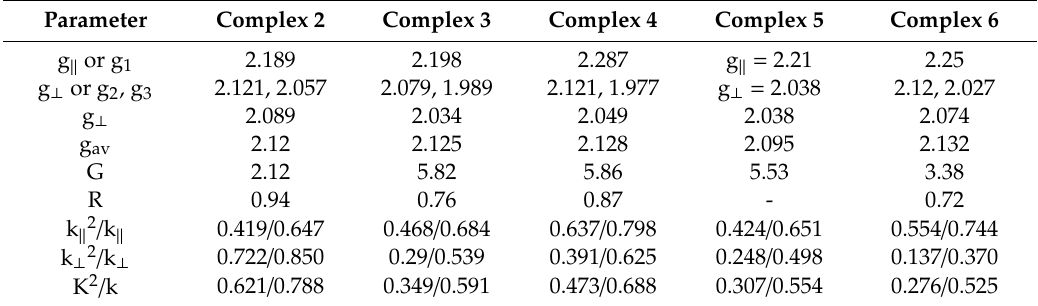
Table 4. EPR spectral assignments and bonding parameters for Cu(II) complexes in polycrystalline state at 298